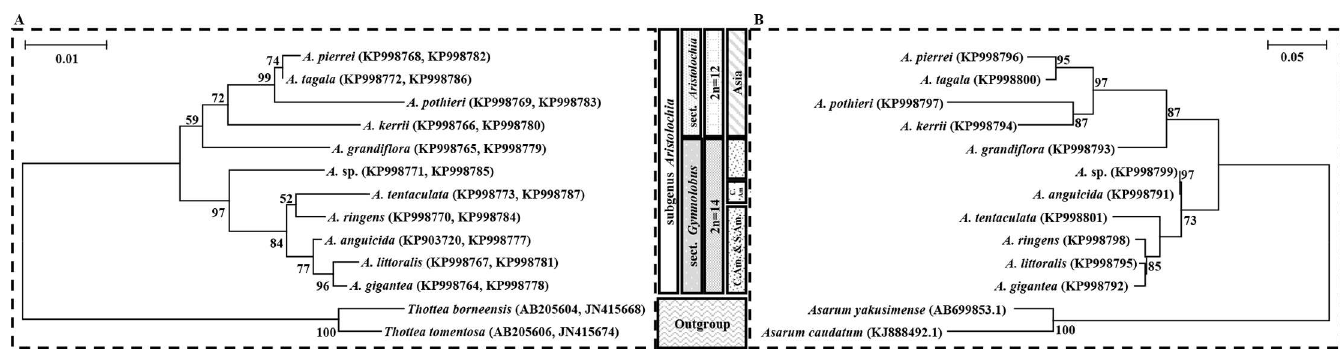
Fig 4. Comparison between the maximum likelihood phylogenetic trees of eleven Aristolochia taxa. (A) the combined data set of the rbc L and mat K genes and (B) the ITS2 nucleotide sequences. Numbers along branches indicate bootstrap percentages (higher than 50%) from the branch-supporting statistical analysis.